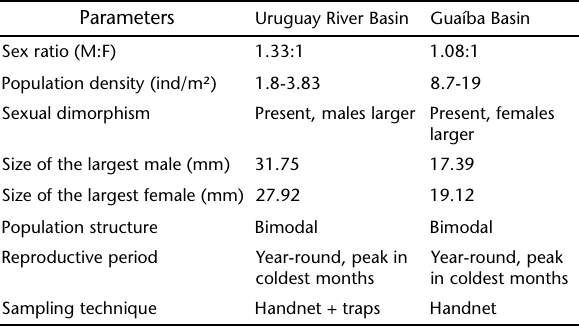
Table V. Sampling methods and population parameters of Aegla platensis evaluated for the populations of the Uruguay River (this study) and Guaíba Basins (B UENO & B OND -B UCKUP 2000), respectively. Parameters